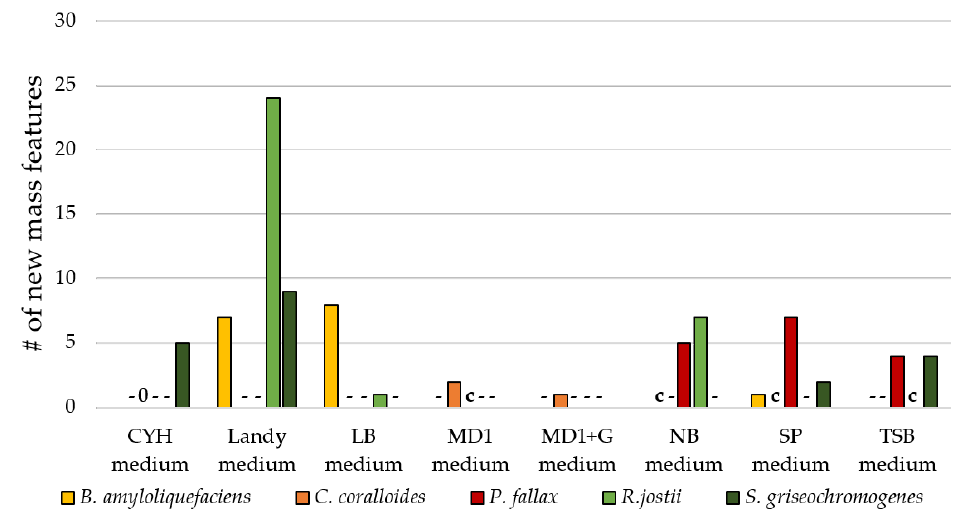
Figure 3. Number of new mass features in extracts of nutrient-rich media experiments. The ‘-’ indicates not tested with this bacterium, the ’0’ related to no new mass features compared with the control group ‘c’. Any new mass feature had to be present in both biological duplicates and its MS signal had to surpass an intensity of 10 5 to be considered for the number of new mass features presented in this diagram. Therefore, this diagram only shows the number of reproducibly detected mass features.